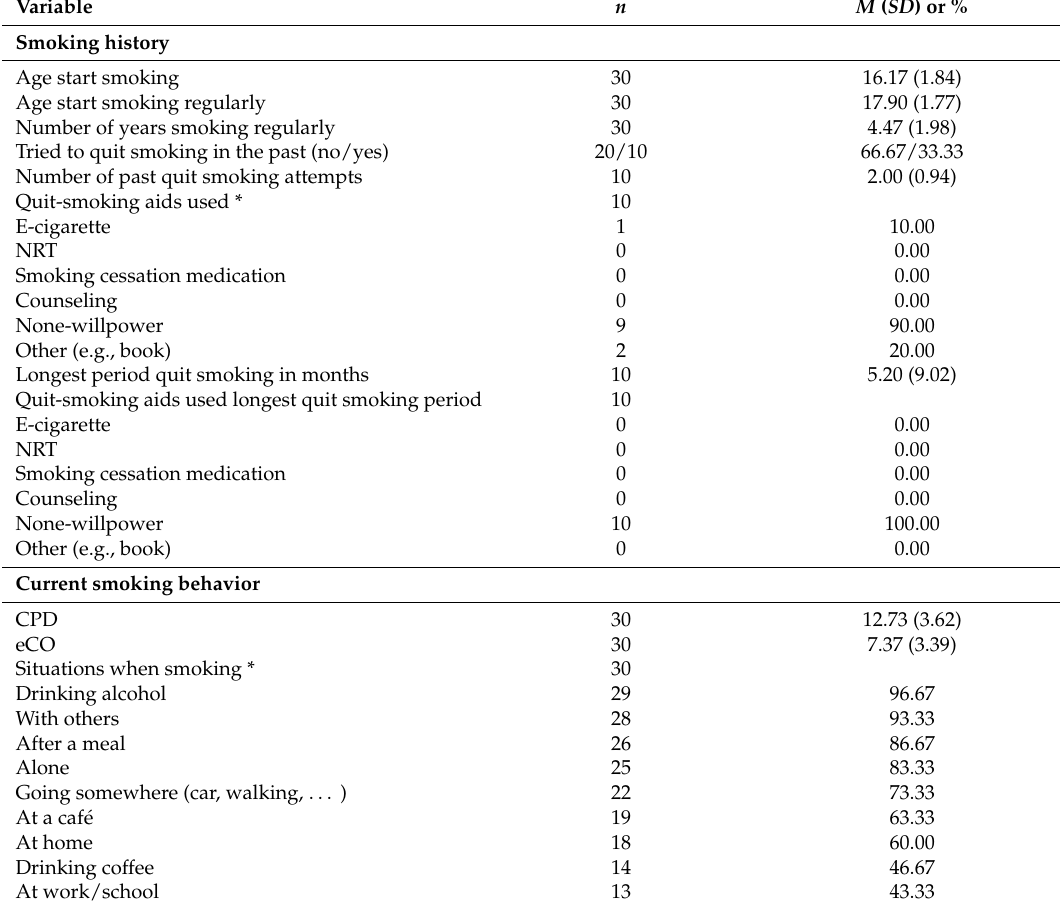
Table A1. Smoking history and current smoking